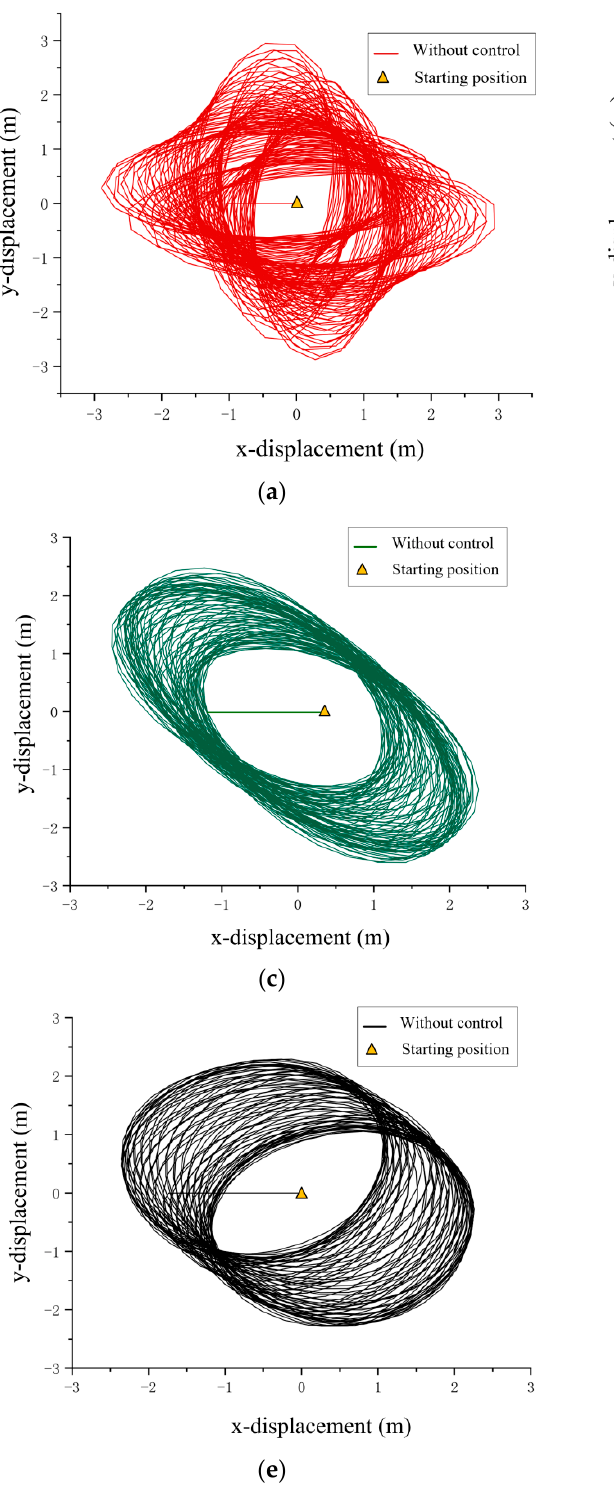
Figure 13. The dynamic response of TTAS under Condition 3. ( a ) The x, y displacement without control of the payload when the hoist cable is 0.6 m; ( b ) the x, y displacement with control of the payload when the hoist cable is 0.6 m; ( c ) the x, y displacement without control of the payload when the hoist cable is 1.2 m; ( d ) the x, y displacement with control of the payload when the hoist cable is 1.2 m; ( e ) the x, y displacement without control of the payload when the hoist cable is 1.8 m; ( f ) the x, y displacement with control of the payload when the hoist cable is 1.8 m.